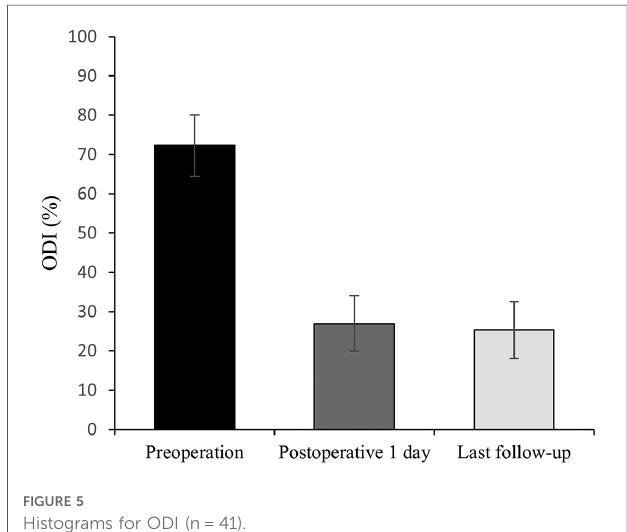
FIGURE 5 Histograms for ODI (n=41).